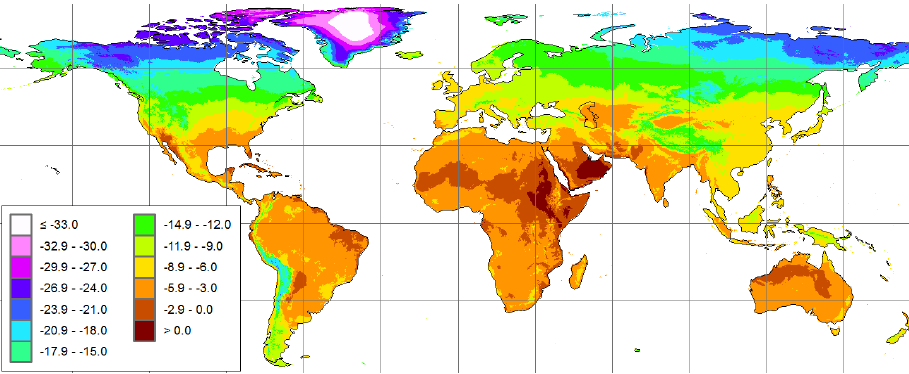
Fig. 12. Predicted global amount-weighted δ 18 O ANN of precipitation obtained using RCWIP. The legend is δ 18 O in ‰ relative to the VSMOW-SLAP scales.